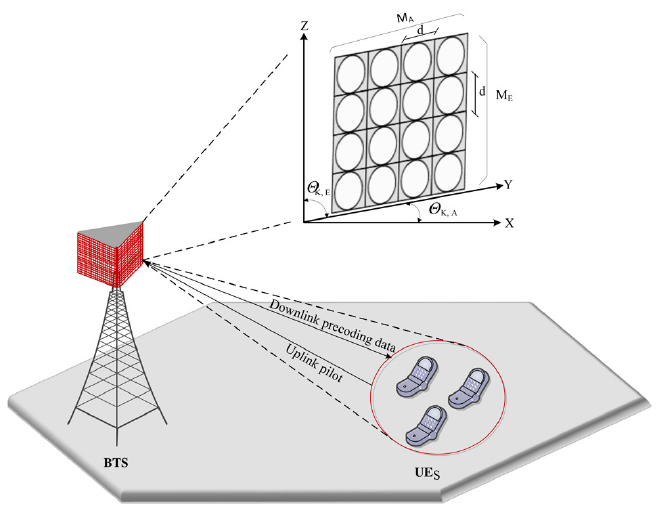
Figure 3. Base station deploys a URA topology, the channel model shows that the propagation link from the UEs to the base station with the azimuth and elevation angles in the coordinate